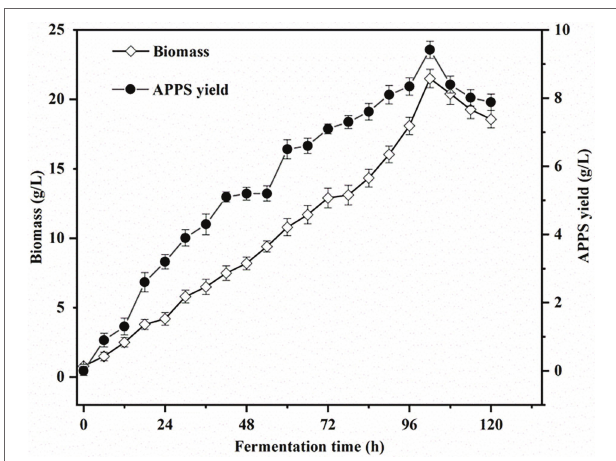
FIGURE 3 | Time distribution of yellow slurry water fermentation system.